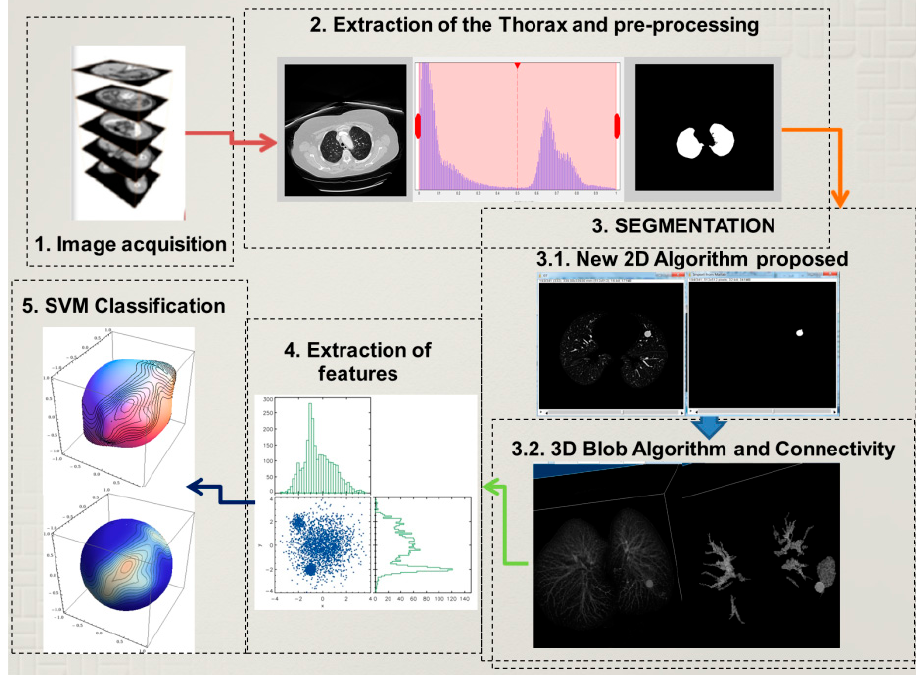
Figure 1. Lung Nodule Detection Process.